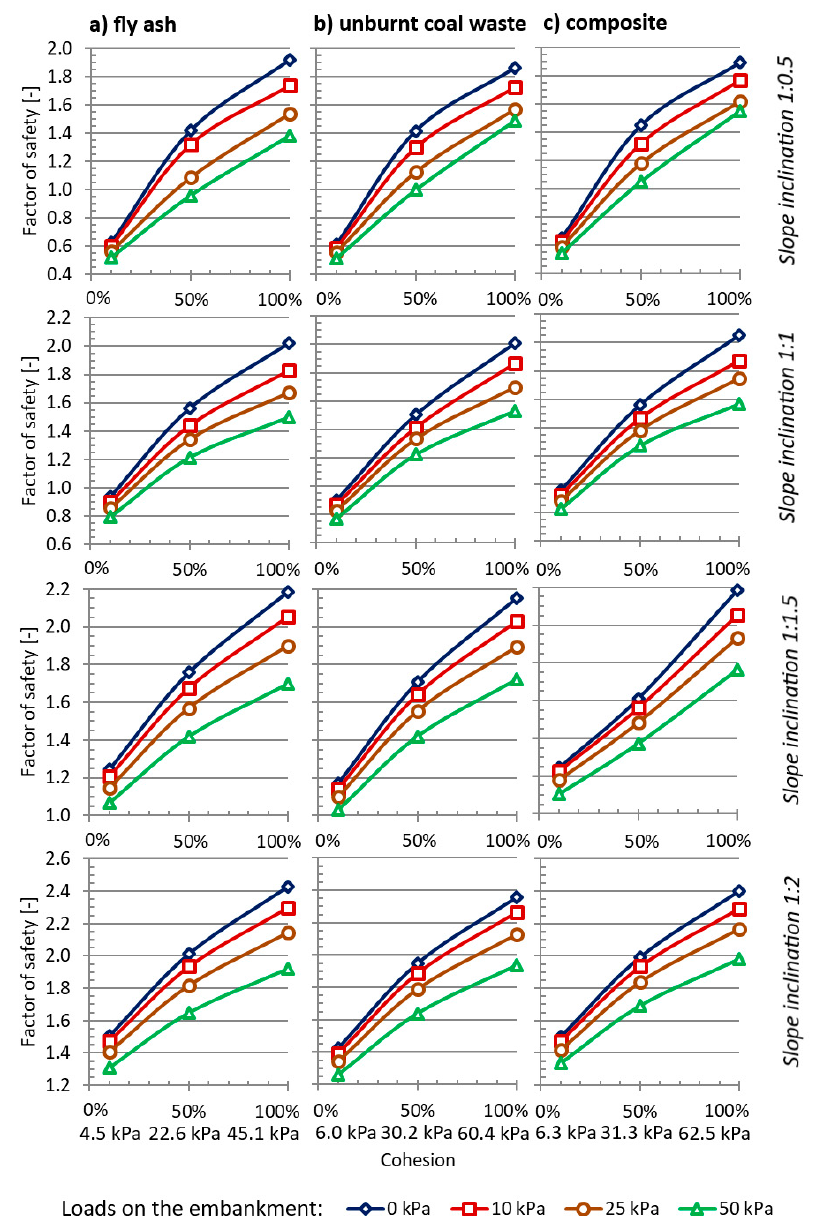
Figure 11. Changes in the factor of safety with increasing cohesion at different loads on the embankment.